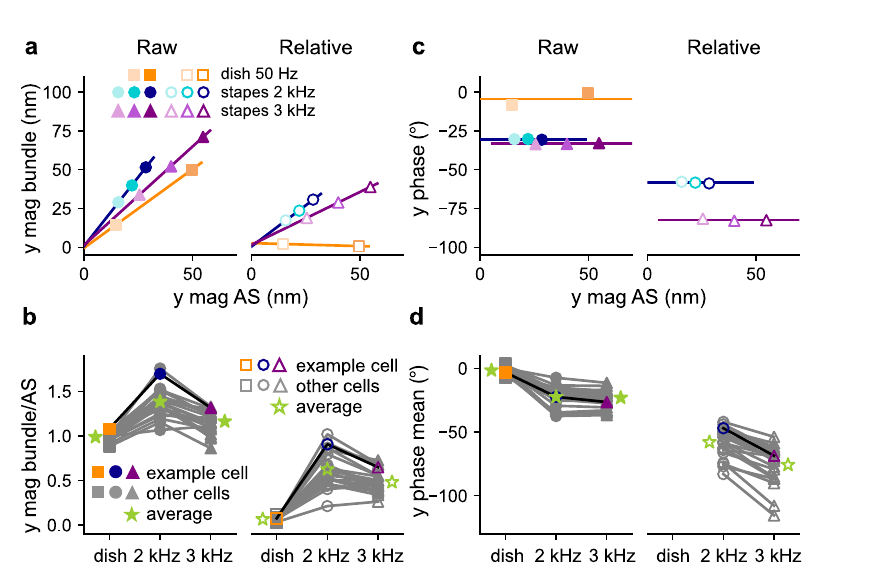
Fig. 3 Comparing raw and relative motion under stapes stimulation at 2 and 3 kHz. a , e , i , m The motion trajectories from an example stereocilium bundle are traced on top of the bundle image (1- µ m scale bar) for raw ( a ) and relative ( e , i , m ) motions, with 10× motion scaling in all panels. The 2-kHz results are in the top panels, and 3-kHz results are in the bottom panels. The same cell appears in both a and e . b , f , j , n The corresponding stereocilium- motion magnitudes in the radial ( y ) direction are plotted as functions of longitudinal position for the corresponding raw and relative motions. c , g , k , o The stereocilium magnitudes in the radial direction, normalized by the radial bundle magnitude (i.e., the mean of the individual stereocilia), are plotted for the example bundles with respect to the longitudinal position. d , h , l , p The corresponding phases of the radial stereocilium motions are also plotted against the longitudinal position. The green arrows in c , d , g point to a stereocilium with large raw motion ( c ) but small relative motion ( g ) and a phase close to that of the apical surface ( d ). The orange arrows in c , g point to two example stereocilia whose raw-motion magnitudes are smaller than some others ( c ), but whose relative-motion magnitudes are larger ( g ). q , r Histograms show the correlation between the 2- and 3-kHz stereocilium motion patterns for all 23 hair bundles, in terms of the normalized magnitude in q and phase in r , for raw (left) and relative (right) motions. For each cell, the normalized magnitudes and phases were averaged across input levels for each frequency. s , t The standard deviation (SD) of the inter-stereocilium magnitudes, normalized by the mean magnitude in the radial direction in s , and the phase SD averaged across levels in t , are compared pairwise between the 2- and 3-kHz stapes stimulations for all cells, with the average value of each group shown as a green star.